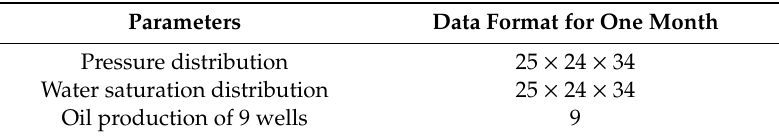
Table 2. Output parameters information in the model.